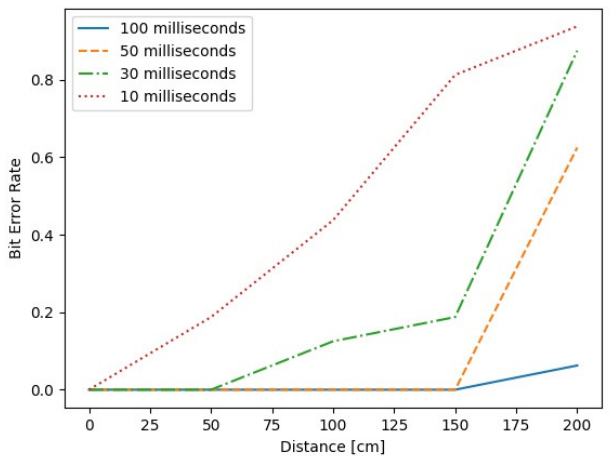
Figure 4. Bit error rate for distance and length per